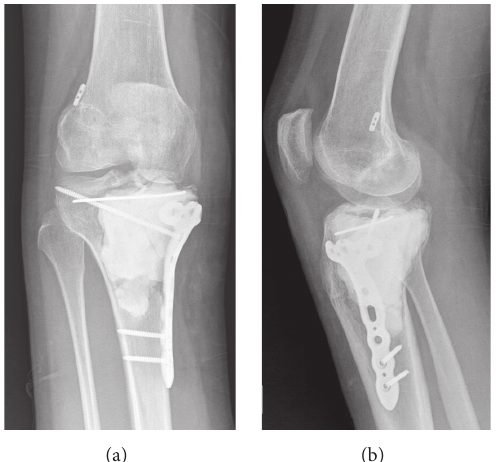
Figure 10: AP and lateral standing radiographs 4 months after giant cell tumor curettage and packing demonstrate stable postoperative